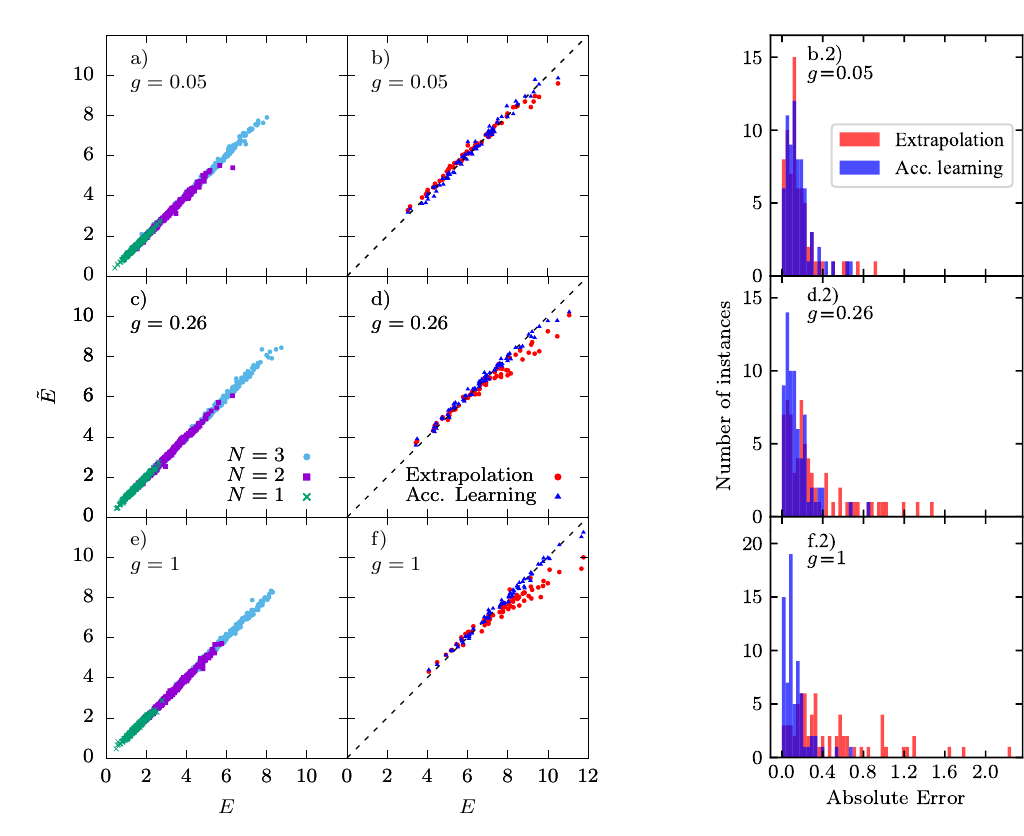
Figure 4: (Left) Ground-state energies ˜ E , predicted by neural networks trained on heterogeneous datasets, as a function of the exact-diagonalization results E . The training sets include 1200 instances for the particle numbers N = 1,2, and 3, for a total of 3600 instances. Panels (a), (c), and (e) report results for the systems sizes included in the training set. Panels (b), (d), and (f) report the extrapolations to the N = 4 case, and the accelerated learning with 200 additional training instances for N = 4. (Right) Panels (b.2), (d.2), and (f.2) show the distributions of the ab- solute error, | ˜ E − E | , for the extrapolations and the accelerated-learning procedure corresponding to panels (b), (d), and (f), respectively. The three rows correspond to different interaction strengths g